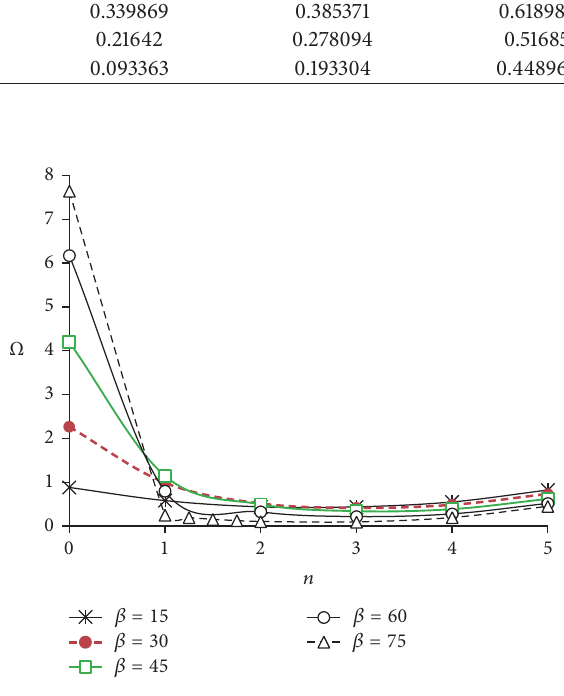
Figure 4: Nondimensional frequency variation of fixed PMMA/ CNT composite shell for 𝑉 ∗ CN = 0.28